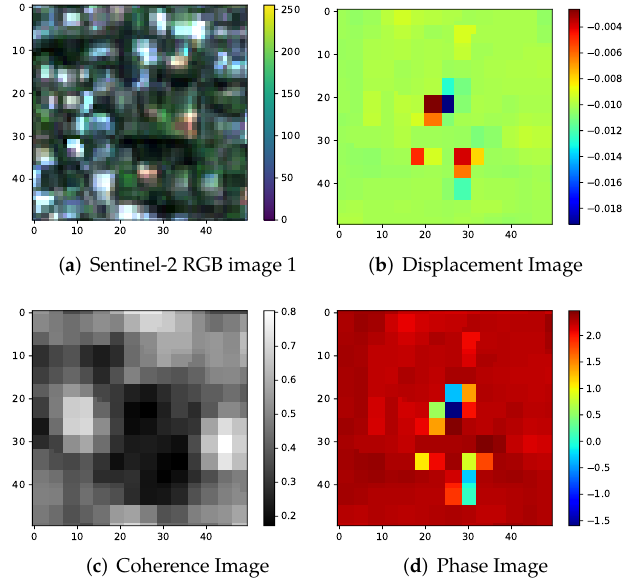
Figure 20. A difficult false-positive blob of trees in Hyde Park.